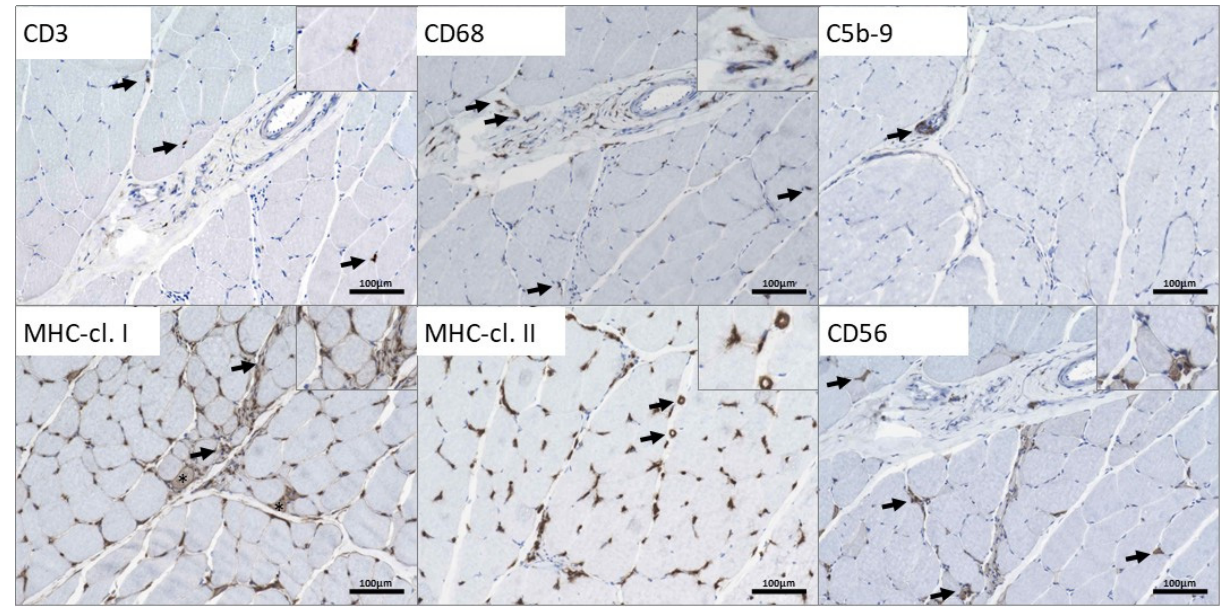
Figure 4. Immunohistological studies focusing on inflammatory proteins in a quadricep muscle biopsy derived from the p.(A20S)-SPTLC1-patient: CD3 staining highlights single T cells in the endomysium and the perimysium (arrows). CD68+ macrophages are diffusely scattered in the endomysium and accumulate around and within a small perimysial nerve fascicle (arrows). Physiological complement accumulation in the perineurium of this nerve (arrow), but not on any sarcolemmal or sarcoplasmic structure of muscle fibers. Single myofibers in perifascicular regions indicate upregulation of MHC cl. I sarcolemmaly (asterix), and some macrophages in the perimysium are also MHC cl. I-positive (arrows). MHC cl. II similarly highlights some macrophages and the partially enlarged capillary vessels (arrows). Small regenerating fibers also express CD56 (arrows).